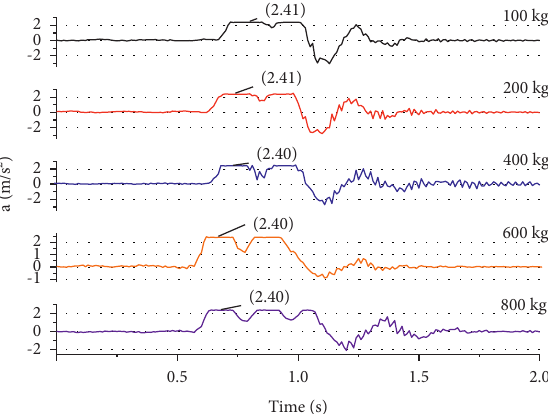
Figure 12: Longitudinal vibrations of the frame during the downward emergency stop.